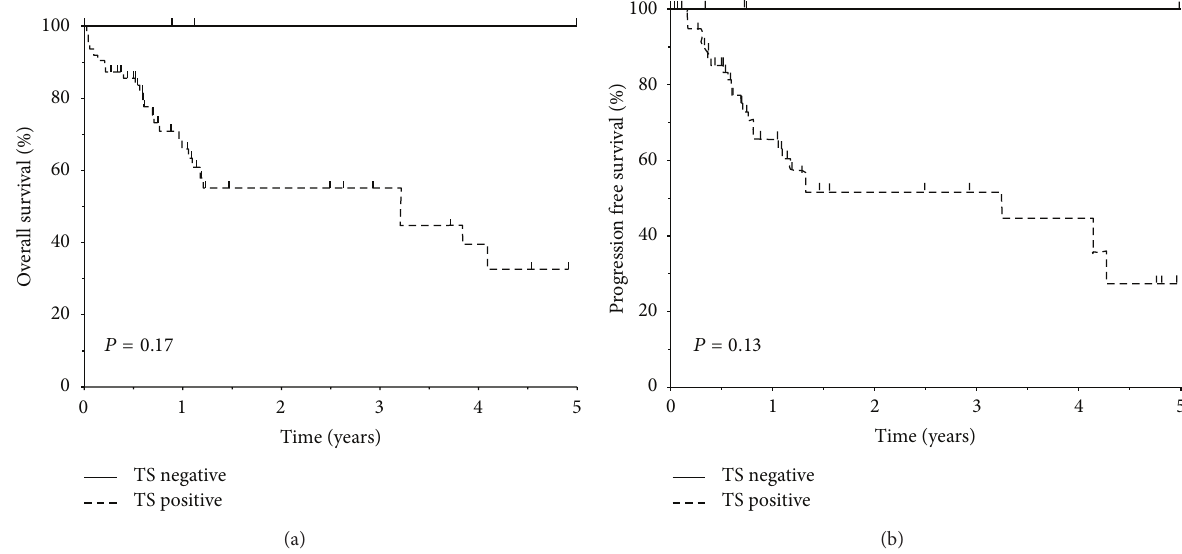
Figure 2: Progression-free and overall survival stratified by tumour TS expression. Four patients with low TS expression had a better outcome than patients with high tumour TS